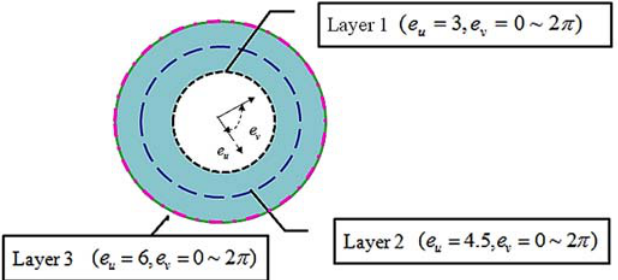
Figure 2. The cloak shell region is divided into three structural layers. The three layers ( e u = 3, 4.5, and 6; e v = 0~2 π ) represent the cloak shell region with anisotropic material properties. (cid:112) (cid:112) λ / ρ = λρ (the definition of specific acoustic impedance), (3b) into relationship z = ρ · c = ρ